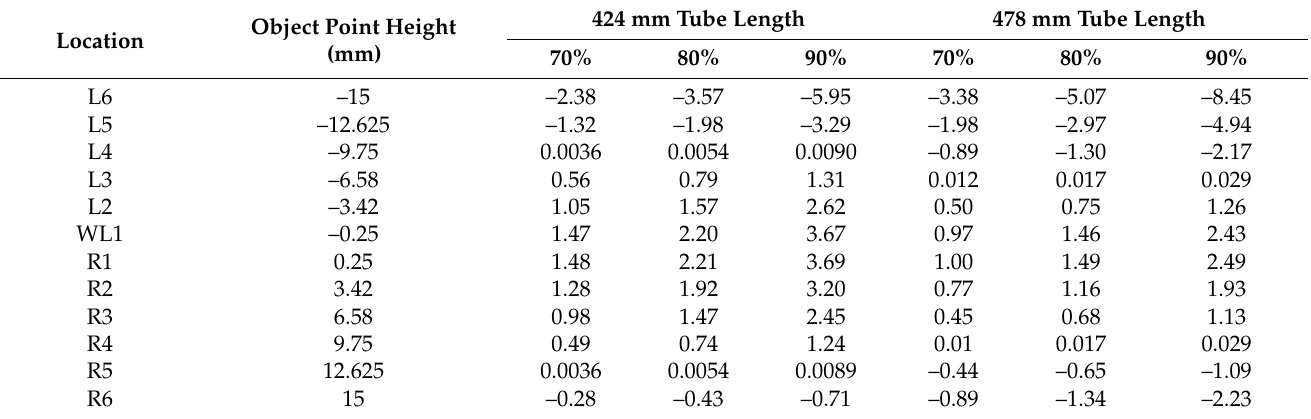
Table 3. Distance between different tube lengths on Petzval image plane and planar screen